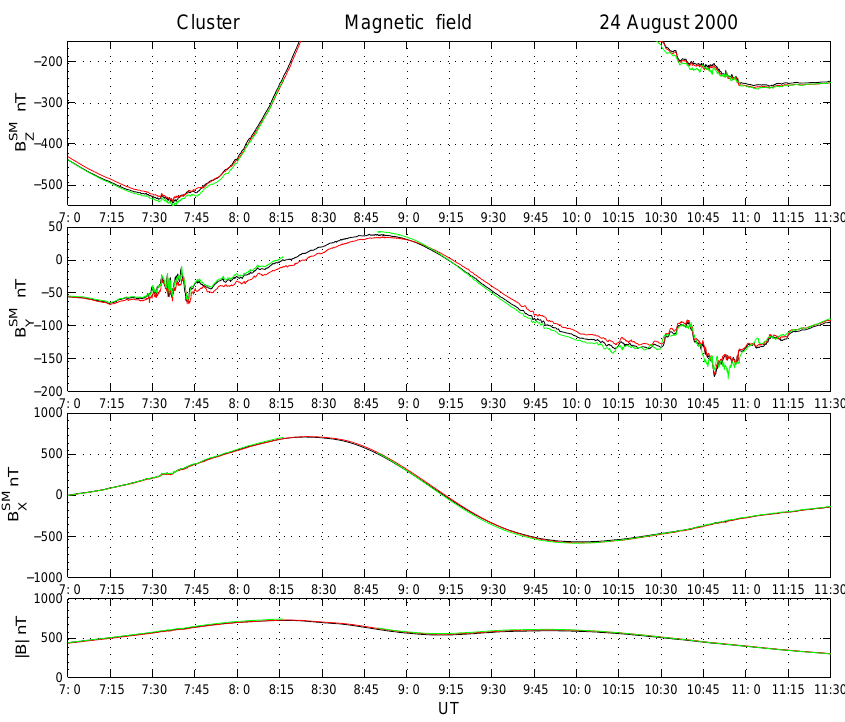
Fig. 1. The Z , Y and X magnetic field components in SM coordinates, and the field magnitude between 07:00 and 11:30UT on 24 August 2000. Data from three spacecraft (1–3) are shown by black, red and green, respectively. There is no data available from spacecraft 4 on this date. Note the disturbed times (07:26–08:00 and